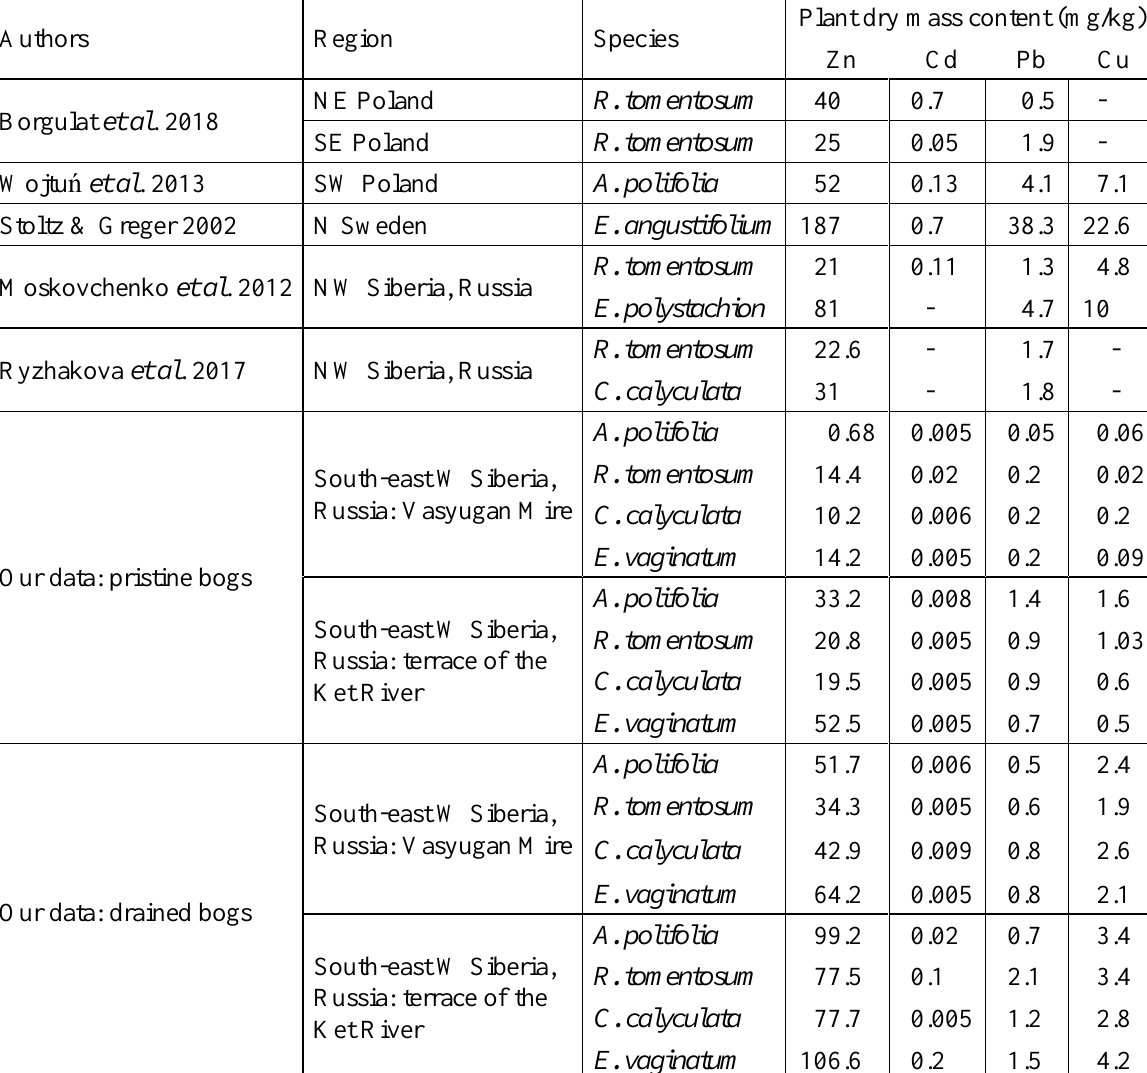
Table 2. Element content of plant dry matter, according to different authors. Authors